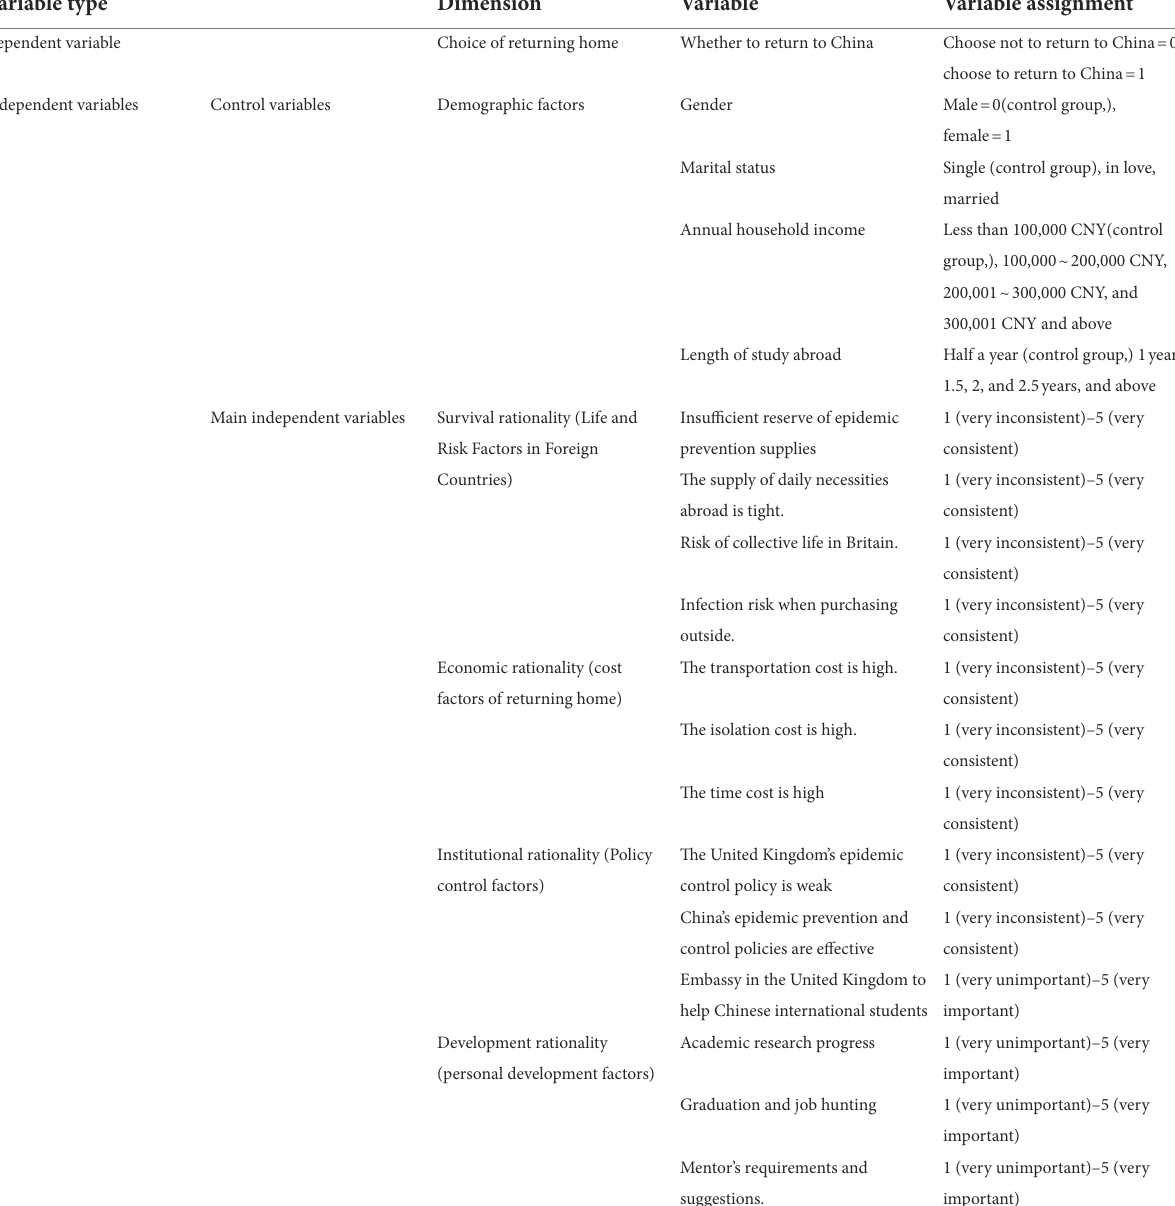
TABLE 4 Setting and description of related